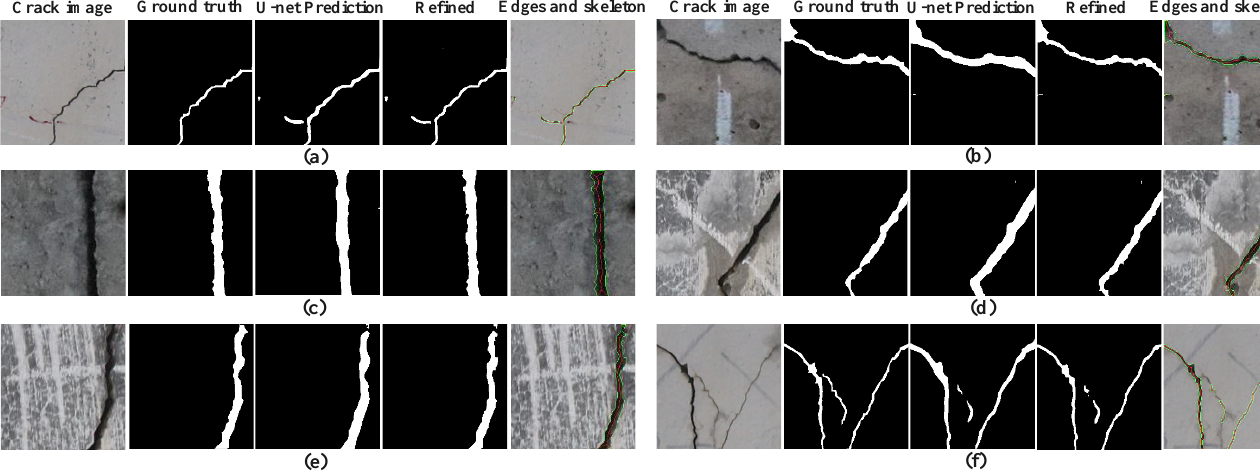
Figure 23. Segmentation results of cracks in outfield captured from different positions. ( a ) clear background, ( b ) dark background, ( c ) blurred boundaries, ( d ) bright background, ( e ) high contrast, ( f ) several cracks. Table 7. Measurement results of six cracks on concrete wall.